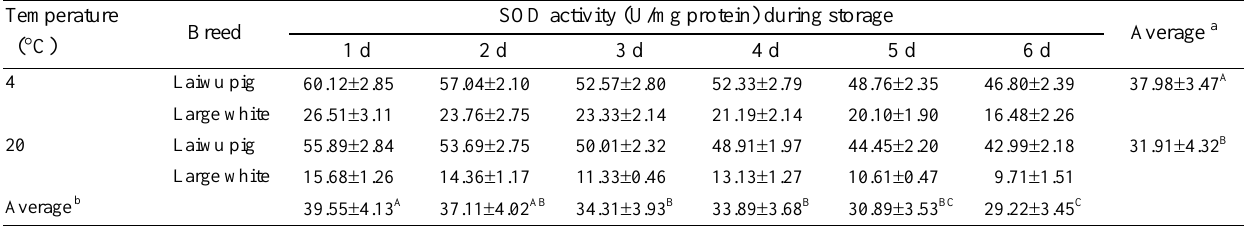
Table 1. SOD activity of porcine muscle stored at different days and temperatures Temperature SOD activity (U/mg protein) during storage Breed